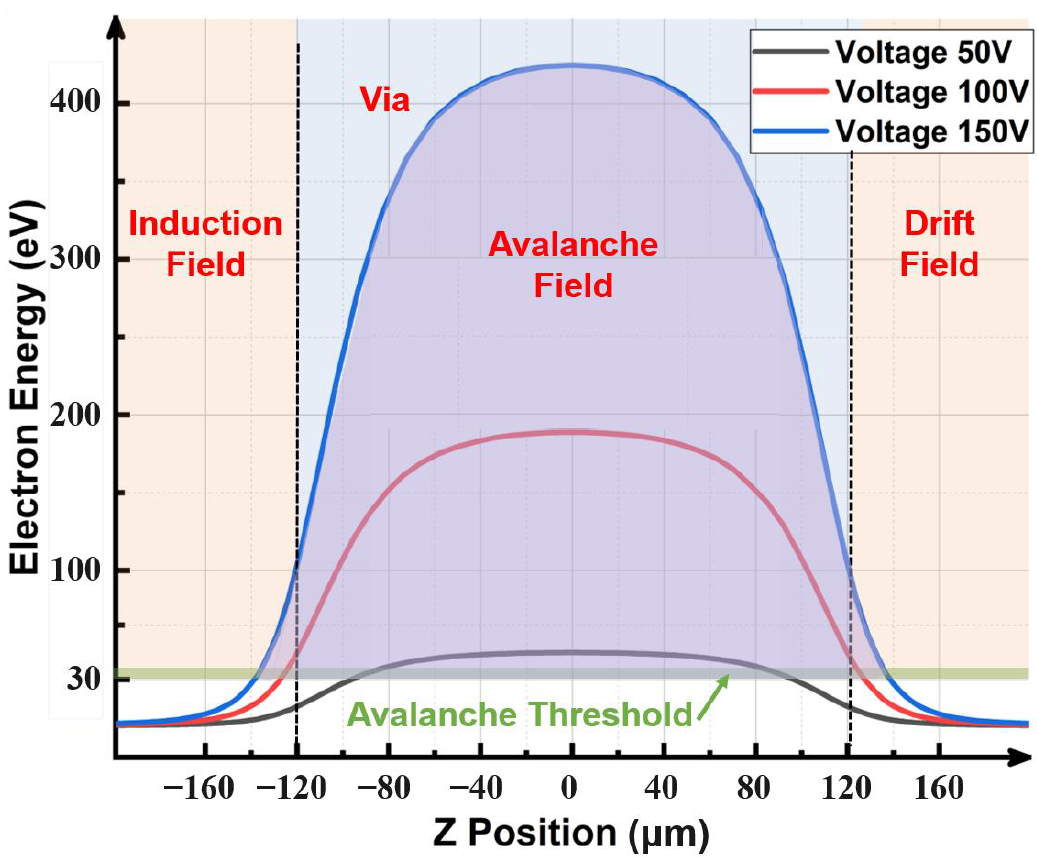
Figure 10. Electron energy in holes.